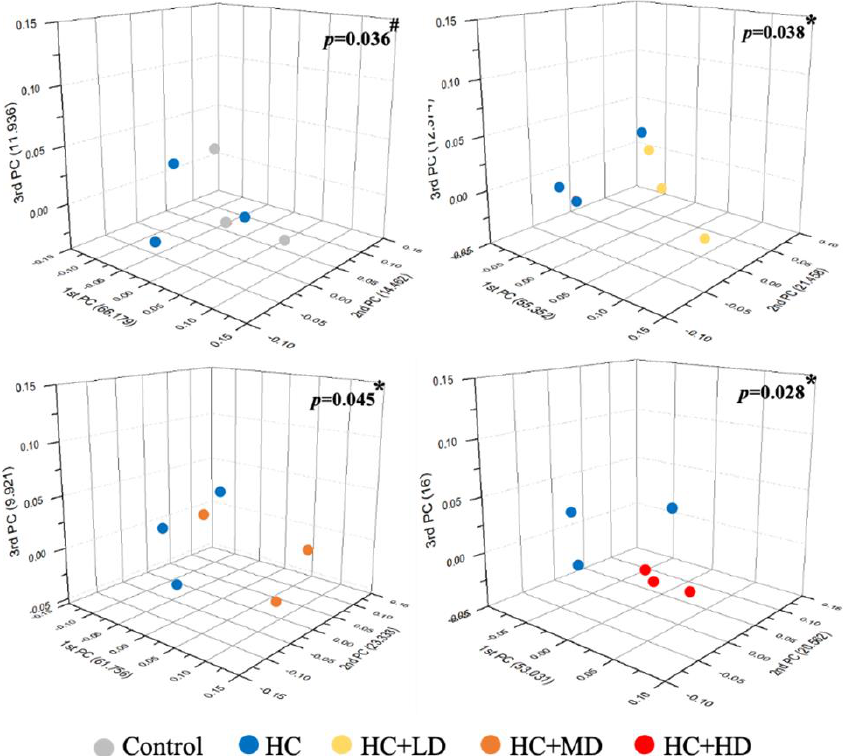
Figure 2. Effect of TCI227 on principal coordinates analysis (PCoA) index levels of fecal microbiota in rats with PO − induced hyperuricemia based on unweighted Jensen − Shannon distance measures of all samples based on OTU − level relative abundance profiles. Results are means for n = 3; # mean values are significantly different from control group ( p < 0.05); * mean values are significantly different from HC group ( p < 0.05) (Jensen − Shannon, genus, exclude unclassified OTU (reads)).